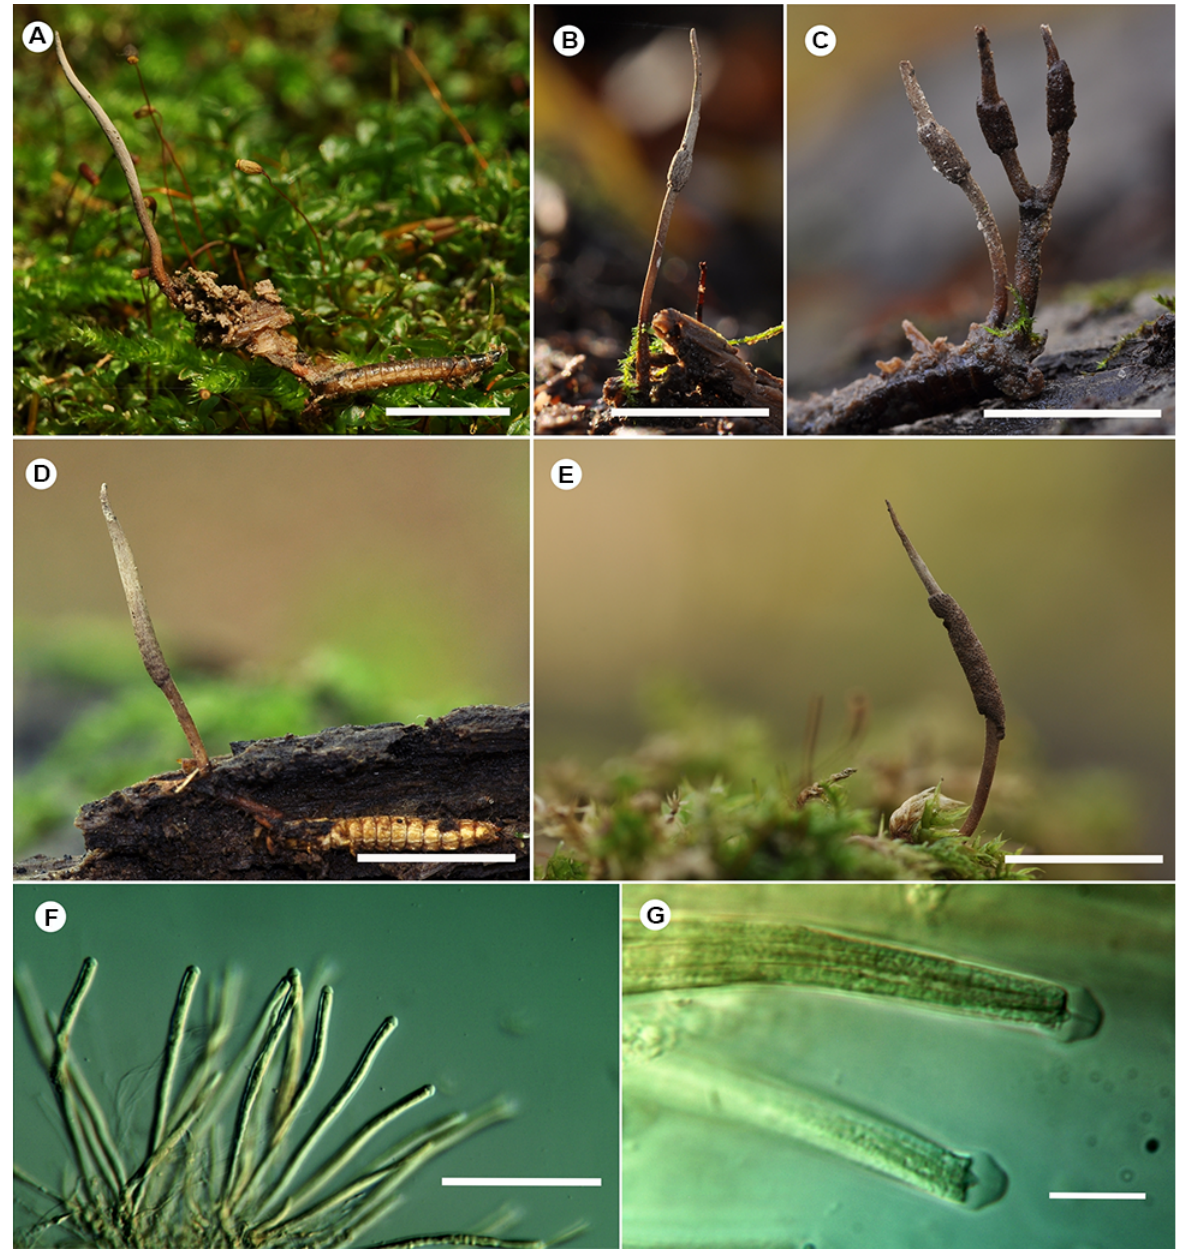
Fig. 3 Ophiocordyceps stylophora – macro- and microfeatures. ( A ) Sterile stroma (anamorph) growing from Elateridae larva. ( B ) Stroma with perithecia (teleomorph) in the initial phase of growth. ( C ) Branched stroma in teleomorphic stage. ( D ) Stroma growing from Tenebrionidae larva. ( E ) Stroma in teleomorphic stage. ( F ) A group of asci. ( G ) Upper parts of asci with ascospores. Scales: ( A–E ) 1 cm; ( F ) 100 µm; ( G ) 10 µm. Photos: P. Stanczak ( A–E ); P. Chachuła ( F,G ). ( A ) July 18, 2014; ( B ) October 22, 2013; ( C ) October 19, 2013; ( D ) September 25, 2014; ( E ) October 23, 2013; ( F,G )